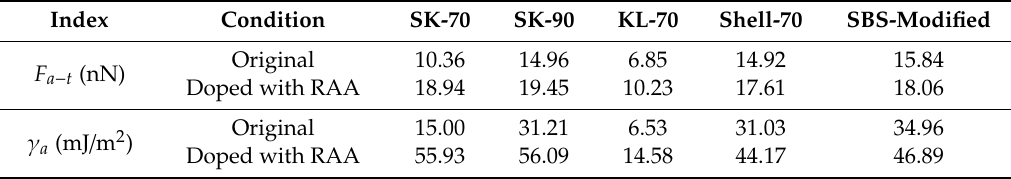
Table 7. the overall surface energies of the original asphalts and those doped with